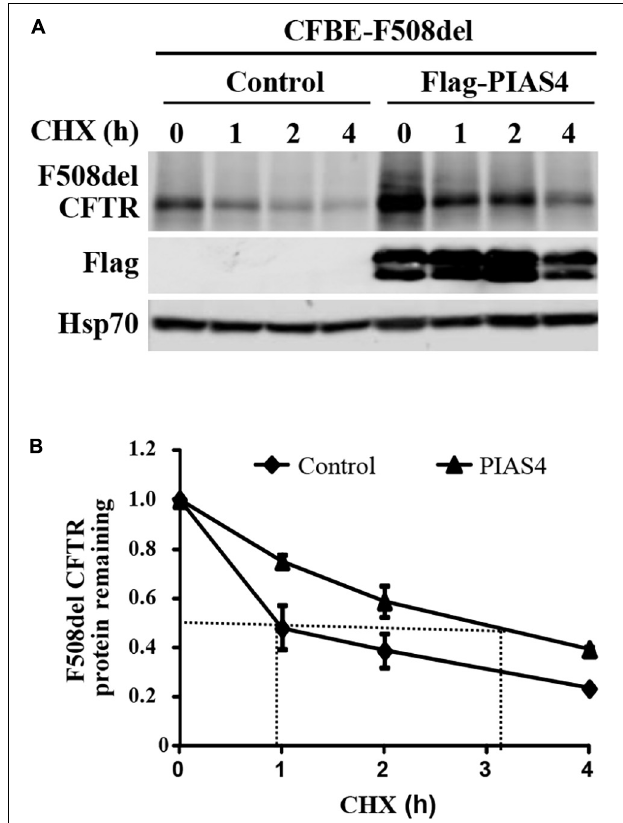
FIGURE 1 | PIAS4 slows F508del cystic fibrosis transmembrane conductance regulator (CFTR) degradation. (A) PIAS4 overexpression increased the expression of F508del CFTR in CFBE airway cells; its impact was greatest on immature CFTR, band B (Gong et al., 2019). This result was clarified by cycloheximide chase experiments, which showed that CFBE cells overexpressing PIAS4 exhibited a 3-fold decrease in the rate of F508del CFTR degradation. (B) Following immunoblot, blot densities from three independent experiments were averaged to construct the relations for F508del CFTR